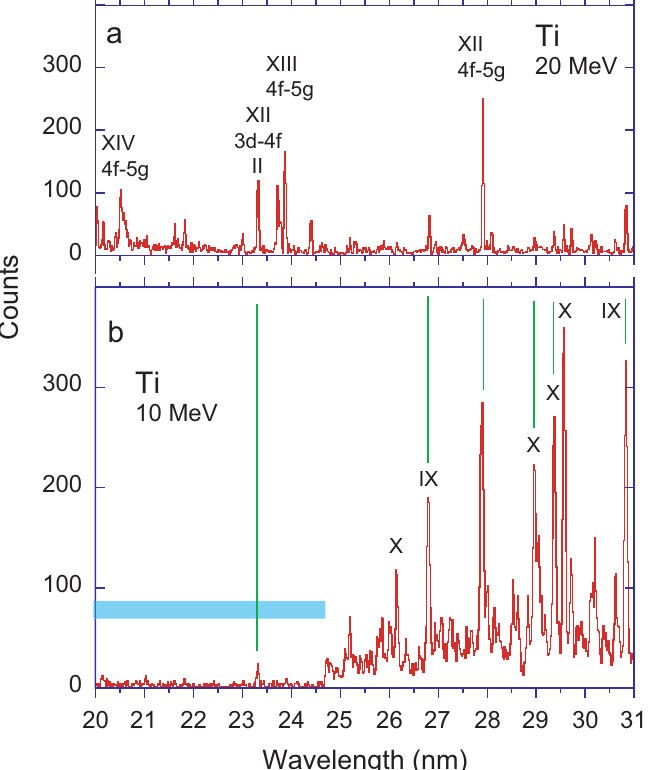
Figure 5. Continuation of the Ti spectra shown in Figure 4. ( a ) ion beam energy 20 MeV, ( b ) ion beam energy 10